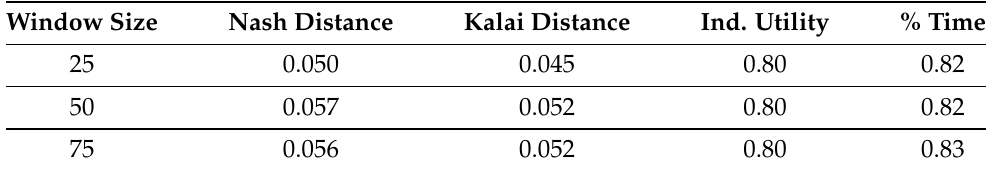
Table 3. Average distance to the Nash bargaining point, to the Kalai point, average individual utility, and ratio of negotiation time consumed for three window